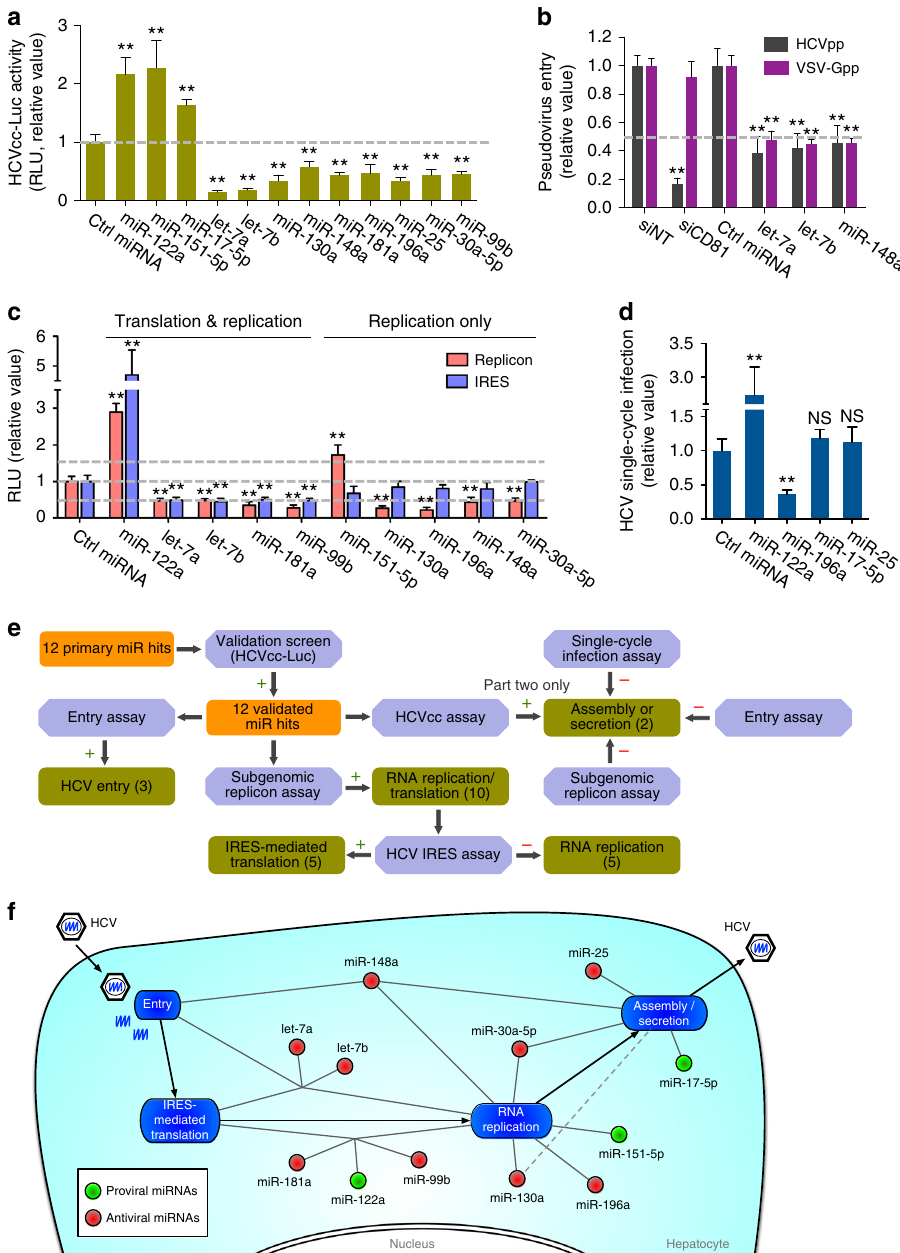
Fig. 3 Impacts of cellular miRNAs on HCV life cycle. a Secondary screen using HCVcc-Luc con fi rmed the phenotypes of primary screen hits in HCV propagation. Relative luciferase activities upon treatment of various miRNA mimics are shown. b Identi fi cation of host miRNAs modulating HCV entry. Graphs show the effects of indicated miRNA mimics on entry of luciferase-encoding pseudotyped viruses bearing HCV (HCVpp) or VSV (VSV-Gpp, serving as a control) envelope proteins. c Identi fi cation of miRNAs regulating HCV IRES-mediated translation or RNA replication. HCV subgenomic replicon and IRES assays were conducted, and miRNA hits exerting signi fi cant effects on HCV RNA replication and/or translation are shown. d HCV single-cycle infection assay (HCVsc) recapitulates viral entry, translation, and replication, but not assembly or secretion of virions. a – d Values are normalized relative to the mimic control (set as 1), and error bars represent SD of the mean, n = 5. ** P < 0.01 determined by Student ’ s t -test. e Schematic fl ow diagram of identifying cellular miRNAs associated with various HCV life cycle stages. f Integrated map depicting interactions of host miRNAs with the entire HCV life cycle. The framework was constructed based on the sequence of HCV infection steps from entry to assembly/secretion. Proviral miRNAs are shown as green circles, and antiviral miRNAs are shown as red circles. The dashed gray line indicates a link between miR-130a and the viral assembly/secretion